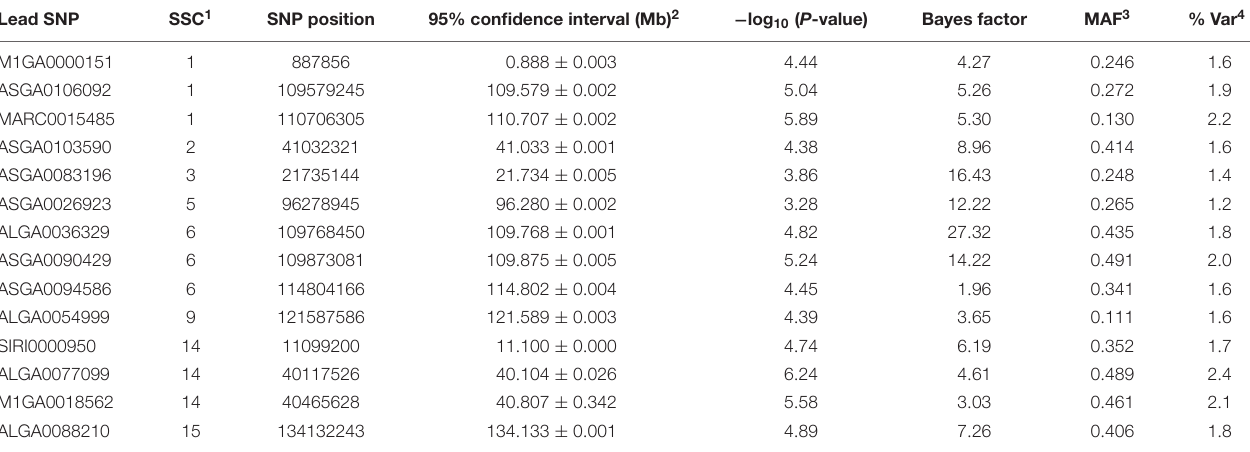
TABLE 3 | Genomic regions and corresponding lead SNPs identified by single- and multi-locus GWAS for levels of IP. Lead SNP SSC 1 SNP position 95% confidence interval (Mb) 2 − log 10 ( P -value) Bayes